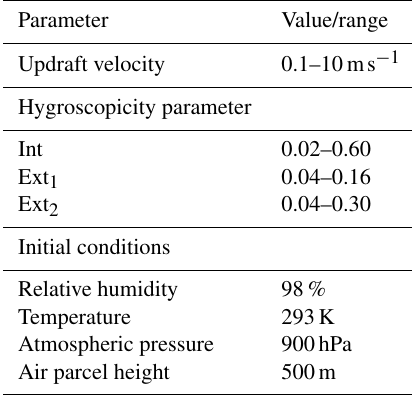
Table 3. Parameters for the